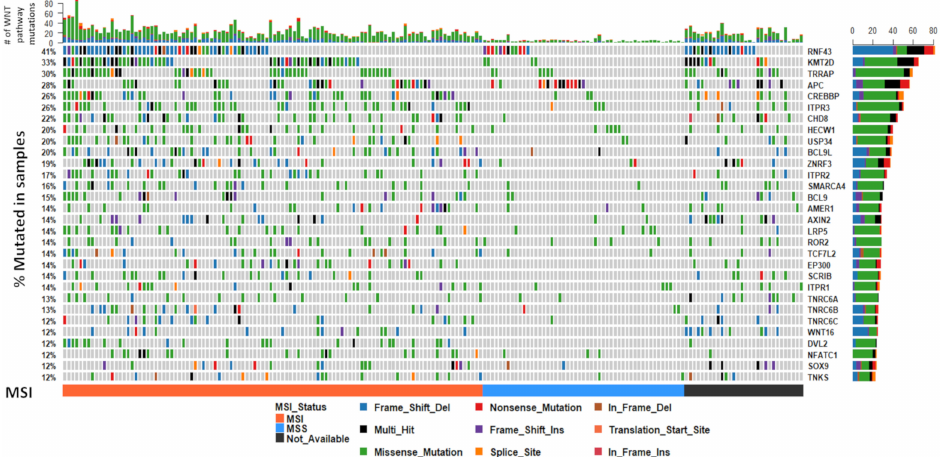
Figure 1. The somatic mutation landscape of WNT signaling regulators in BRAF mutant colorectal cancers. The 30 most frequently mutated genes in the WNT pathway are depicted. Each column corresponds to a single cancer. The colors of bars are indicative of the type of mutation, with grey = wild-type. The barplot at the top of the figure represents the number of mutations in the WNT pathway a sample has. The vertical plot on the right of the figure represents the number of mutations in each gene, color coded by mutation type. Microsatellite instability status is indicated below the mutation